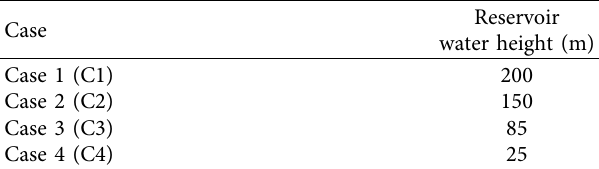
Table 3: Reservoir water heights for earthquake